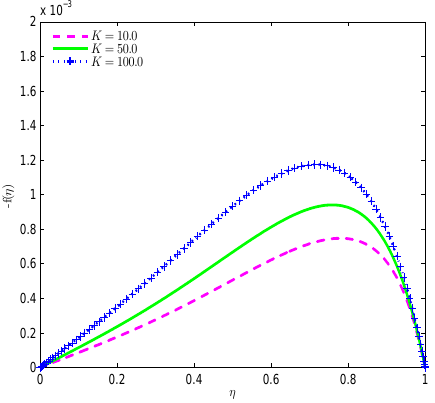
Fig. 10: Variation of f with K at α = 0.01 , β = 0.005 , γ = 0.01 , Re = 10.0 and Λ = 0.001 .